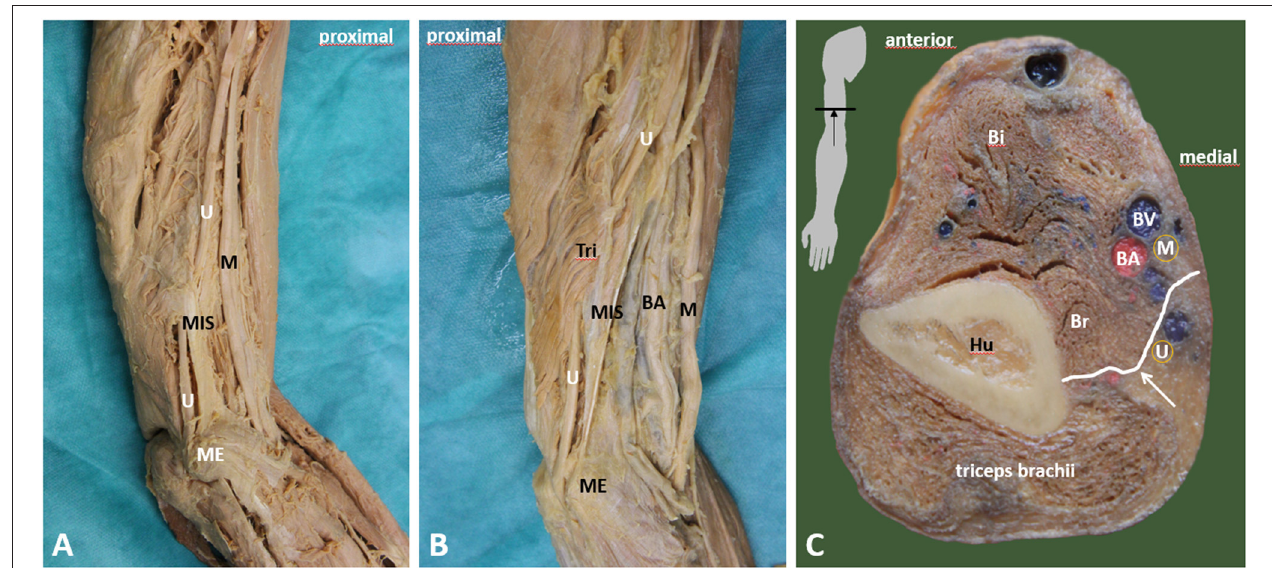
FIGURE 2 | Course of the ulnar nerve in the arm. (A) Relationship of the ulnar nerve ( U ) and the medial septum ( MIS ). Ulnar nerve penetrates the medial septum—the penetration is demarcated by a ligamentous thickening (Struther’s arcade). (B) Penetration of the septum and further course of the ulnar nerve is covered by muscular fibers of medial head of triceps brachii muscle, which begins on the medial intermuscular septum. (C) Transverse section of midarm depicting the relationship between ulnar nerve ( U ) and medial intermuscular septum (white arrow). BA, brachial artery; Bi, biceps brachii muscle; Br, brachialis muscle; BV, brachial vein; Hu, humerus; M, median nerve; ME, medial epicondyle; MIS, medial intermuscular septum; U, ulnar nerve; white arrow, medial intermuscular septum.